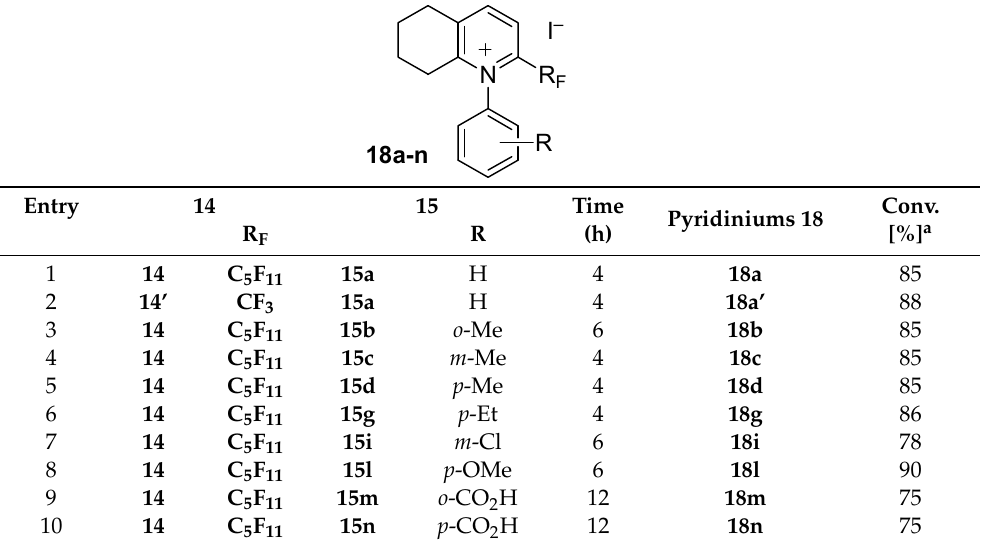
Table 2. Reaction conditions and conversions for the preparation of substituted 2-trifluoromethyl-/2- perfluoroalkyl- N -(R-phenyl)-5,6,7,8-tetrahydroquinoliniums 18a – n , using cyclohexanone 16u as reactant.